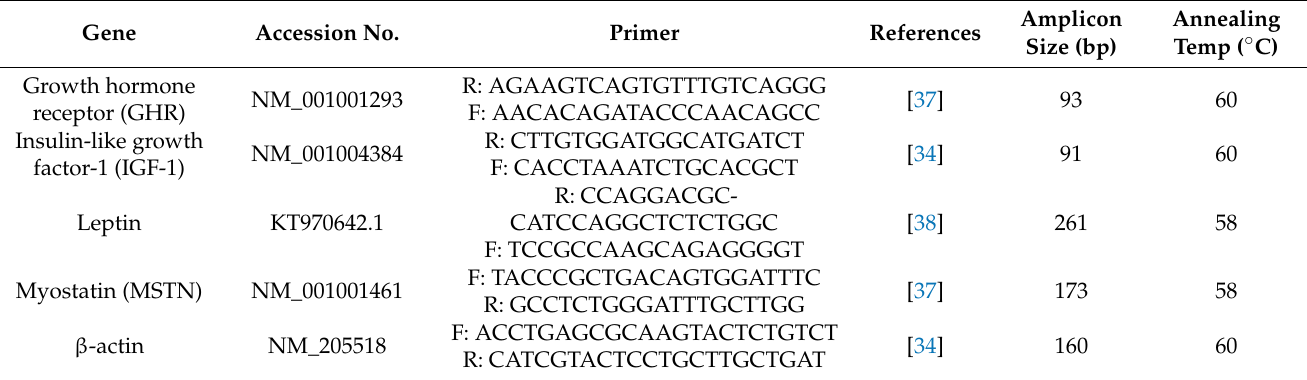
Table 3. Gene-specific primers sequence used in the